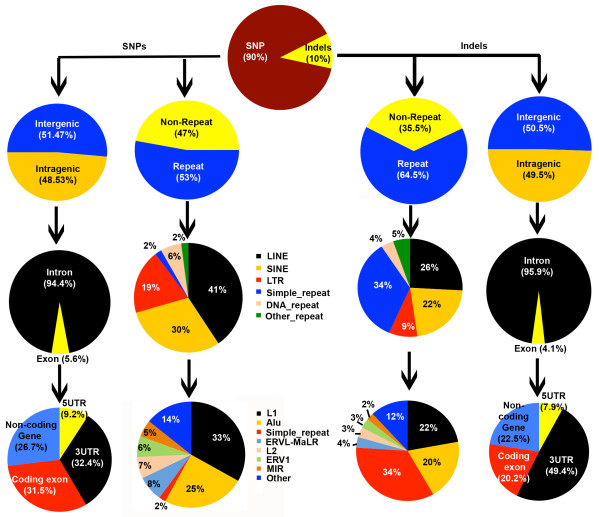
Annotation of SNPs and Indels. The SNPs and Indels coordinates were compared with gene boundary, exon boundary, untranslated and protein-coding regions, repeats, repeat classes and subclasses.